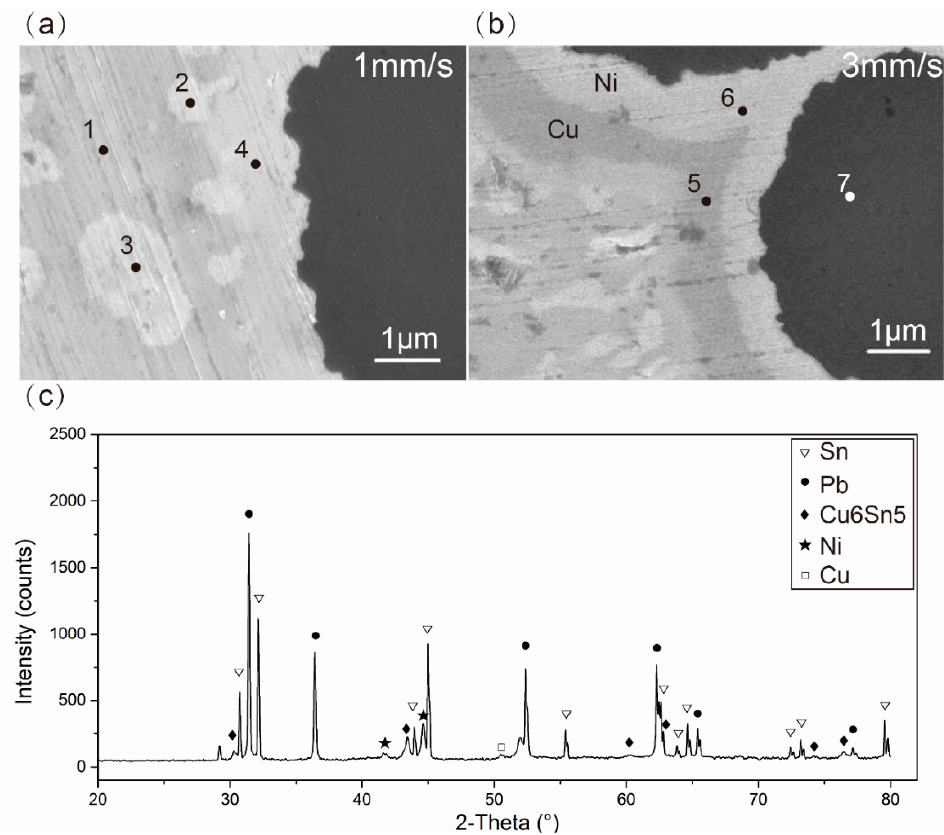
Figure 8. Images of fiber-matrix interface of ( a ) S1 and ( b ) S3 observed with higher magnification scanning electron microscope SEM;( c ) x-ray diffraction (XRD) analysis of the interfacial reaction products. Table 7. Thickness of Cu+Cu6Sn5 vs. tensile strength.